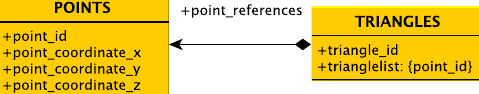
Figure 14: Storing Triangle